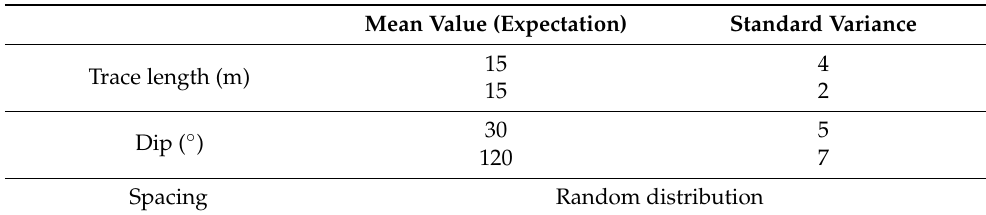
Figure 14. Model of a DFN. Table 5. Distribution parameters of the two groups of fractures.